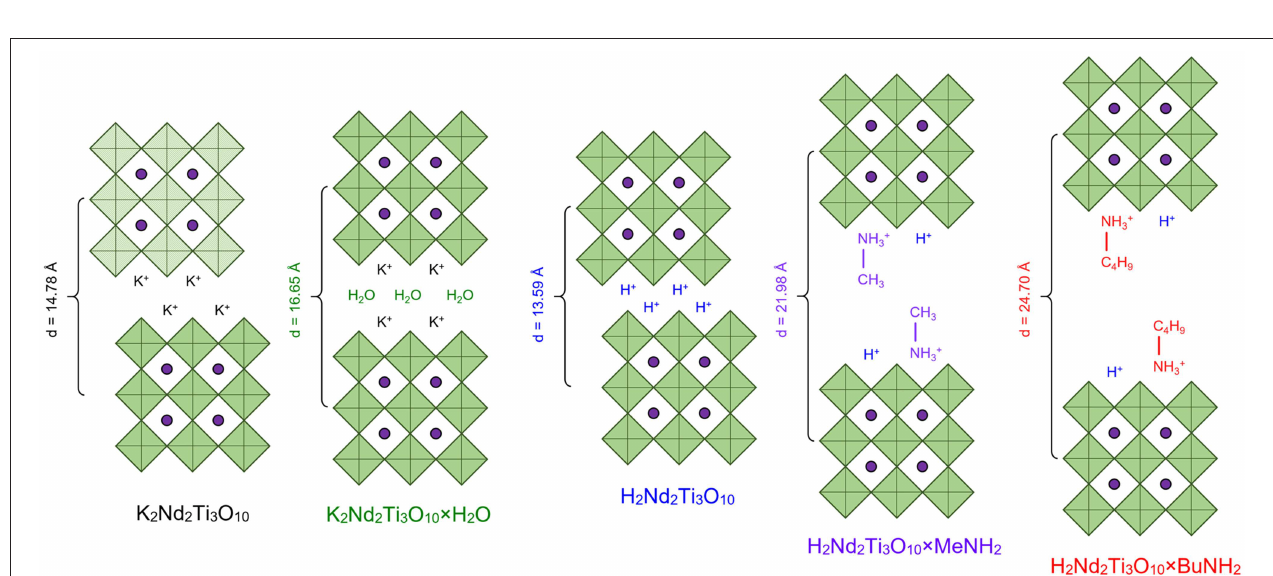
FIGURE 4 | Schematic representation of the interlayer distance change at different synthetic steps.